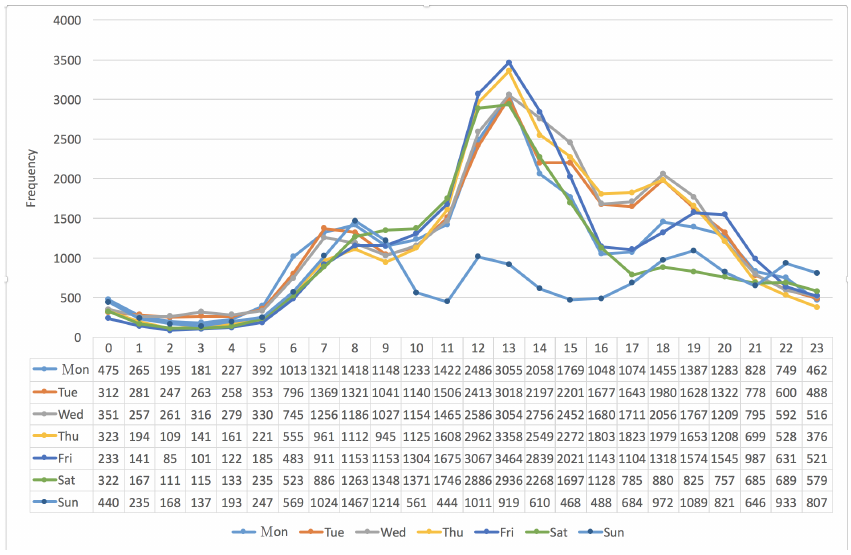
Figure 10. The frequency distribution of vehicles in the southern (S) direction vs. “24 h per day” and “seven days per